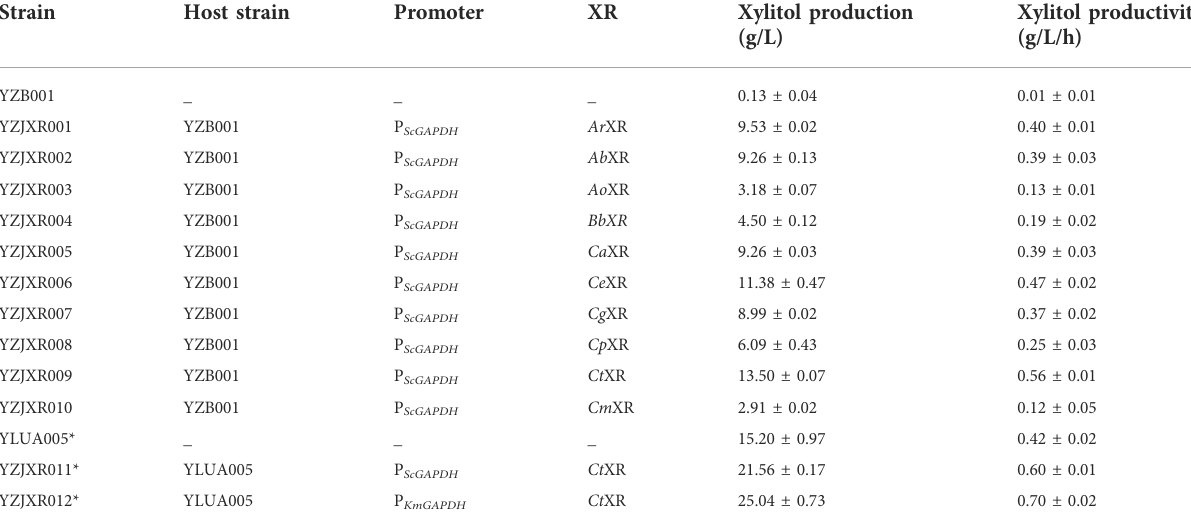
TABLE 3 Fermentation of the strains harboring different XR genes under Sc GAPDH or Km GAPDH promoter. Strain